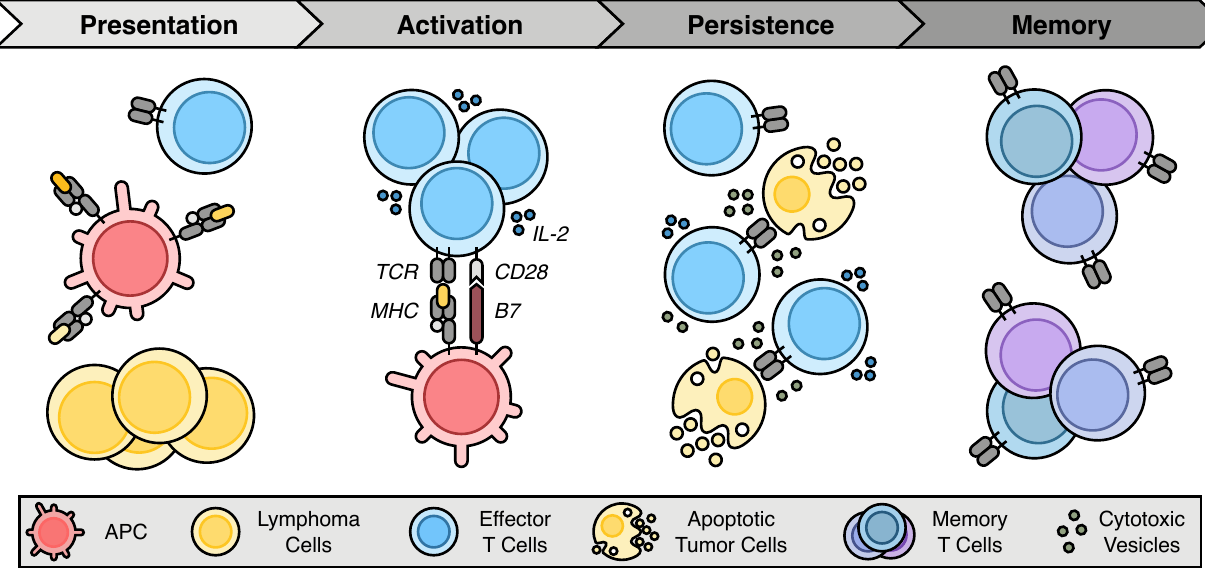
Figure 2. An adequate immune response in lymphoma. An appropriate antitumor immune response requires four funda- mental steps. First, tumor antigens must be recognized as foreign via presentation in the context of major histocompatibility complex (MHC) domains. Presentation is classically accomplished by an antigen-presenting cell (APC), such as a dendritic cell or a macrophage. Following recognition, the second step is the activation and expansion of immune effector cells. In the case of T-cells, this requires costimulation and sufficient cytokine support. Third, the effector cell populations must persist in sufficient quantities and maintain activity until the malignant cell cohort is eliminated in its entirety. Ideally, the immune response would culminate in immunologic memory capable of swiftly responding to future tumor antigen